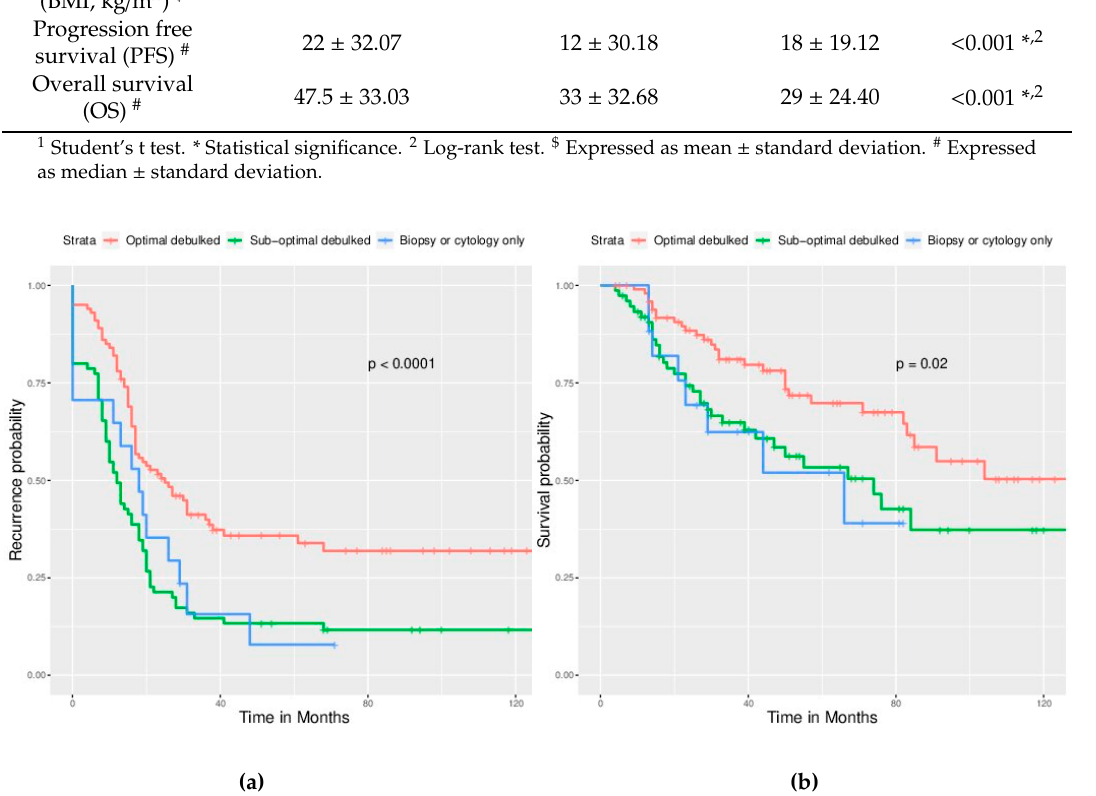
Figure 1. Among survival curves by surgical completeness, significantly better survival can be observed in the optimally debulked group. ( a ) Progression free survival (PFS), p < 0.0001. ( b ) Overall survival (OS), p = 0.02. However, no significant survival difference between the sub-optimal debulked group and non-debulked group. ( p is not shown).